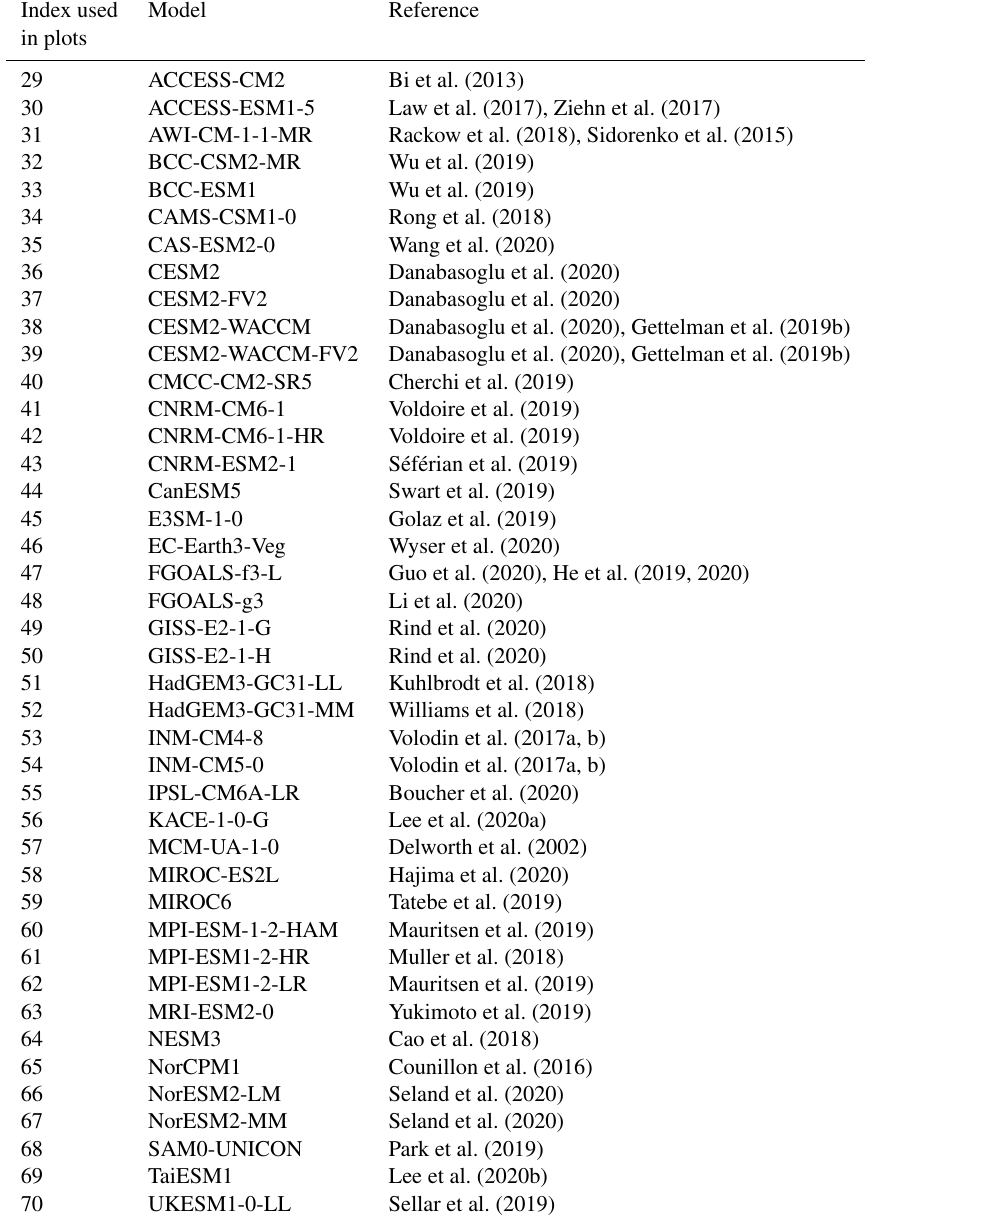
Table 3. As in Table 2 but for CMIP6 models included in this